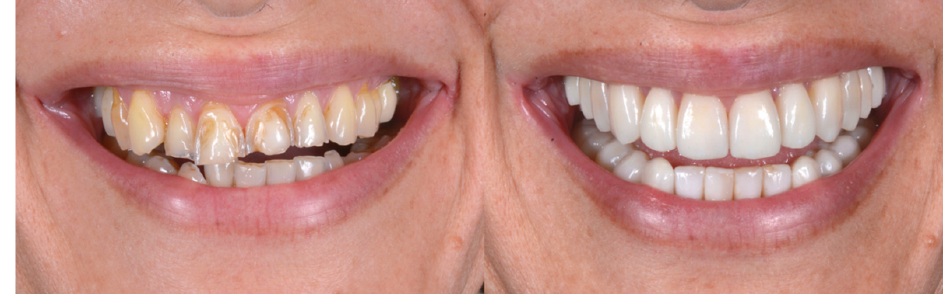
Figure 11. Comparison of the initial and final situation. Orthodontic treatment and anatomical reconstruction of eroded teeth allowed us to create the reconstitution of physiological occlusal dynamics (Figure 12-13).